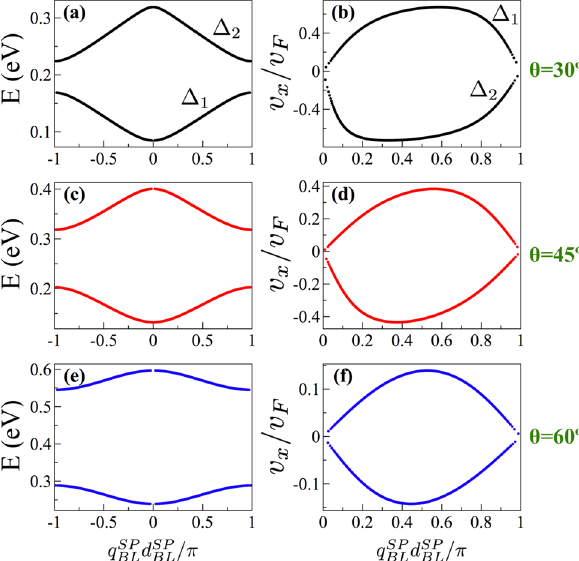
Figure 13. (First column) Low-energy dispersion relation and (Second column) group velocity v x of SPGGSLs for different angles of incidence as indicated. The single-period superlattice parameters are: V 0 = 0.1 eV, d B = 50 a and d W 1 = 60 a . (cid:31) 1 and (cid:31) 2 represent the first and second electron energy minibands,